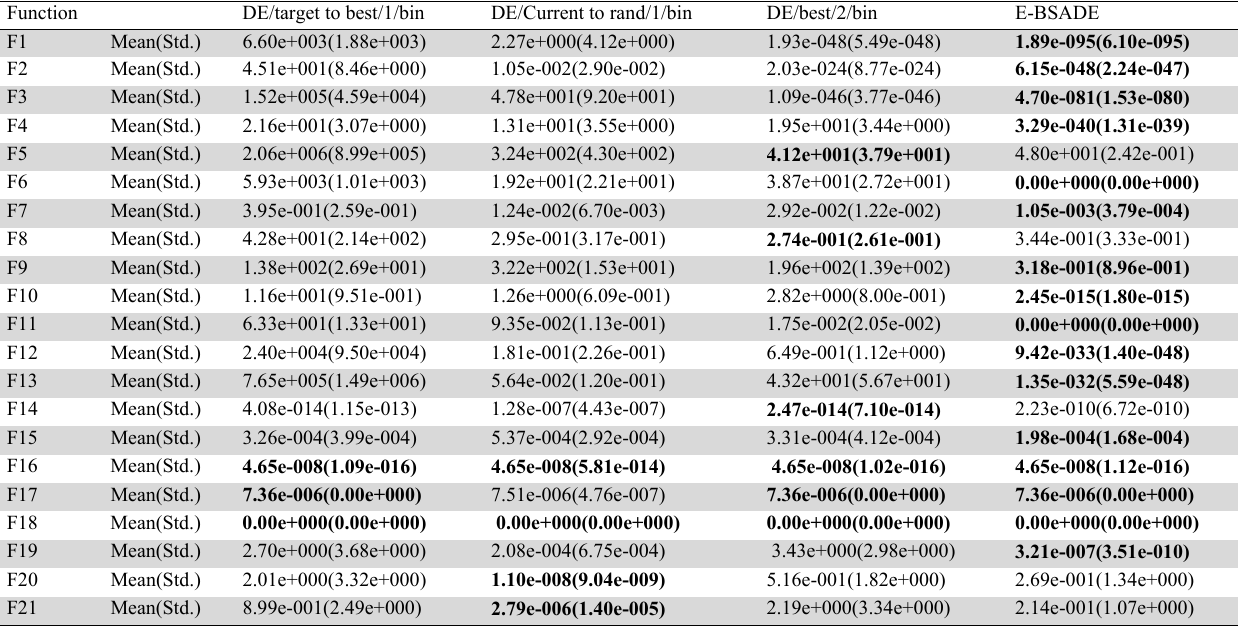
Comparative statistical results of 21 benchmark function of E-BSADE with respect to other DE Mutation Strategies. Function DE/target to best/1/bin DE/Current to rand/1/bin